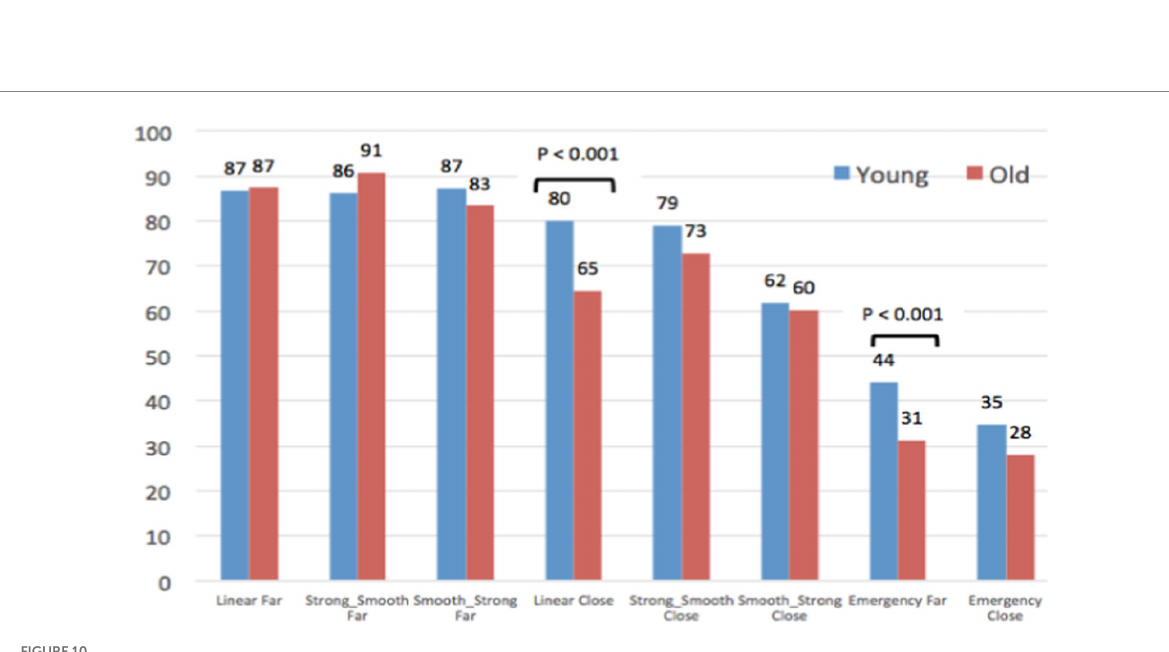
FIGURE 10 Evaluation of the safety of the AV yielding behaviors, as an AV